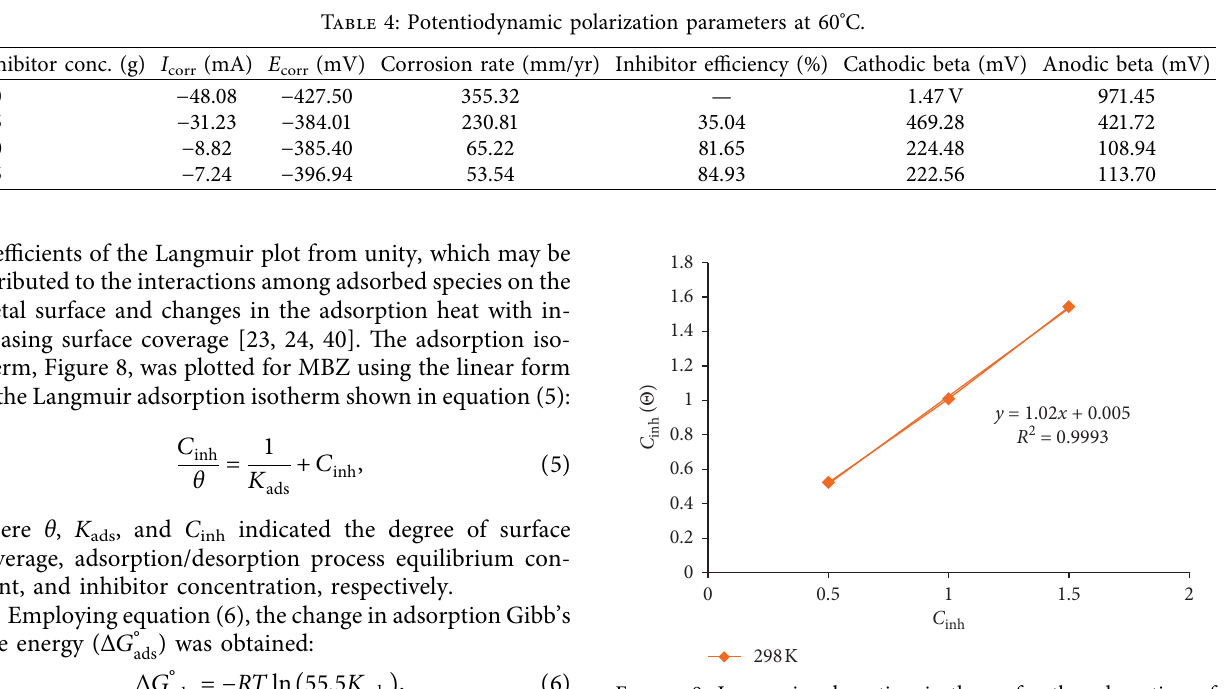
Figure 8: Langmuir adsorption isotherm for the adsorption of MBZ on mild steel in dilute H 2 SO